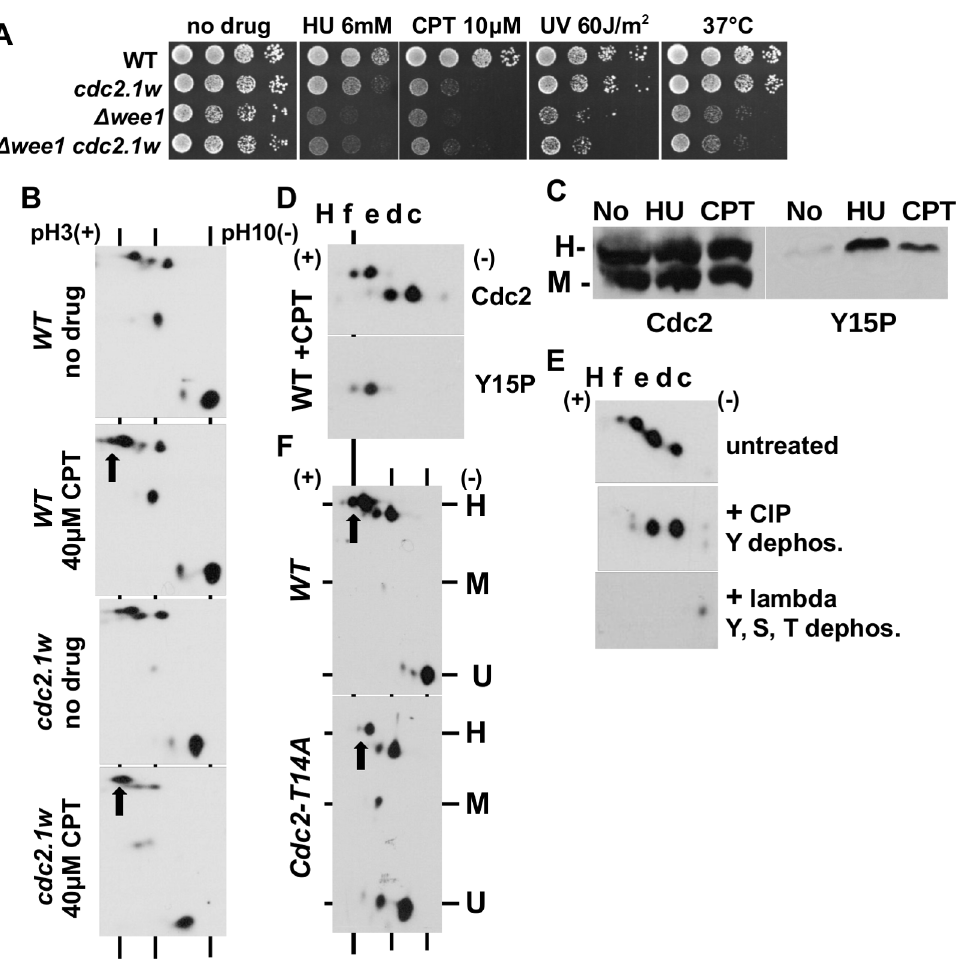
Fig 3. Only Cdc2-He and Cdc2-Hf are phosphorylated at tyrosine 15. (A) Serial dilutions (10-fold; starting with 10 7 cells/ml) of the listed strains were spotted onto YEA plates containing the indicated drugs. The plates were incubated at 30°C for 3 days. One YEA plate was incubated at 37°C. (B) IEFPT analysis of wild type and cdc2 . 1w cells grown in rich medium with 40 μ M camptothecin (CPT) or without the drug. The arrows indicate the increase in the abundance of the Cdc2 forms He and Hf. (C) Phos-tag analysis of total protein extracts prepared from wild type cells grown in rich medium with 12mM HU (hydroxyurea causes DNA replication arrest), with 40 μ M CPT (camptothecin causes DNA replication fork damage) or no drug. The total protein extracts were probed with the anti-Cdc2 antibody (left panel) or the anti-Cdc2-Y15 phospho-antibody (right panel). (D) Cdc2 was immunoprecipitated with an anti-Cdc2 antibody from CPT-treated wild type cells. The enriched kinase was either probed with the anti-Cdc2 antibody (top panel) or the anti-Cdc2-Y15 phospho- antibody (bottom panel). Only the H range is shown. (E) Cdc2 was immunoprecipitated with an anti-Cdc2 antibody from CPT-treated wild type cells and treated with Calf Intestinal Alkaline Phosphatase (CIP), which dephosphorylates tyrosine, with lambda protein phosphatase, which dephosphorylates tyrosine, threonine and serine, or left untreated. The protein was detected with the anti-Cdc2 antibody. (F) IEFPT analysis of wild type and cdc2 . T14A cells grown in rich medium without a